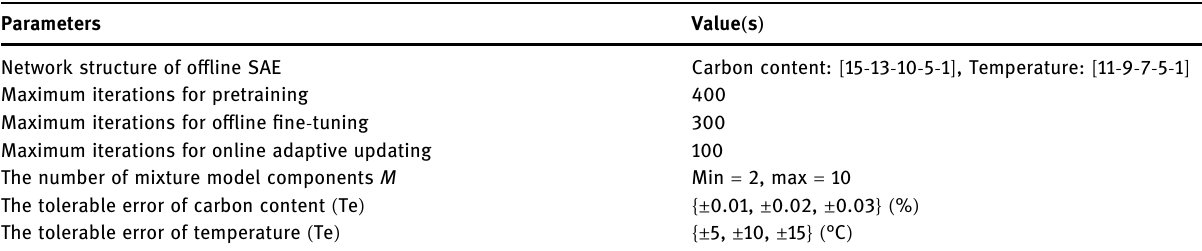
Table 5: The parameter settings